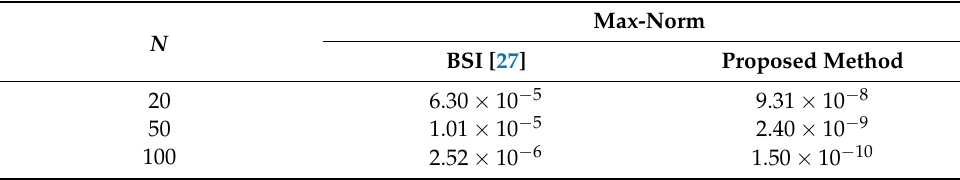
Table 9. Comparison of maximum errors for Problem